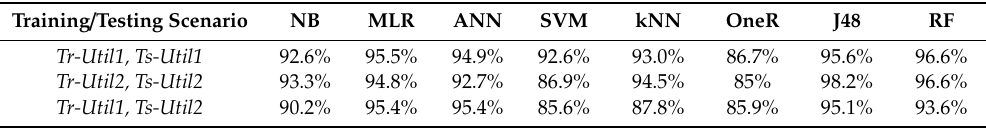
Table 4. Summary of full-feature mean accuracy rate results for the eight classifier types with the three training / testing